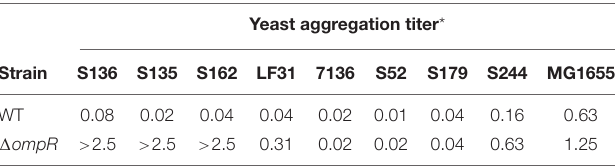
TABLE 2 | Yeast aggregation titer for the WT and (cid:49) ompR AIEC